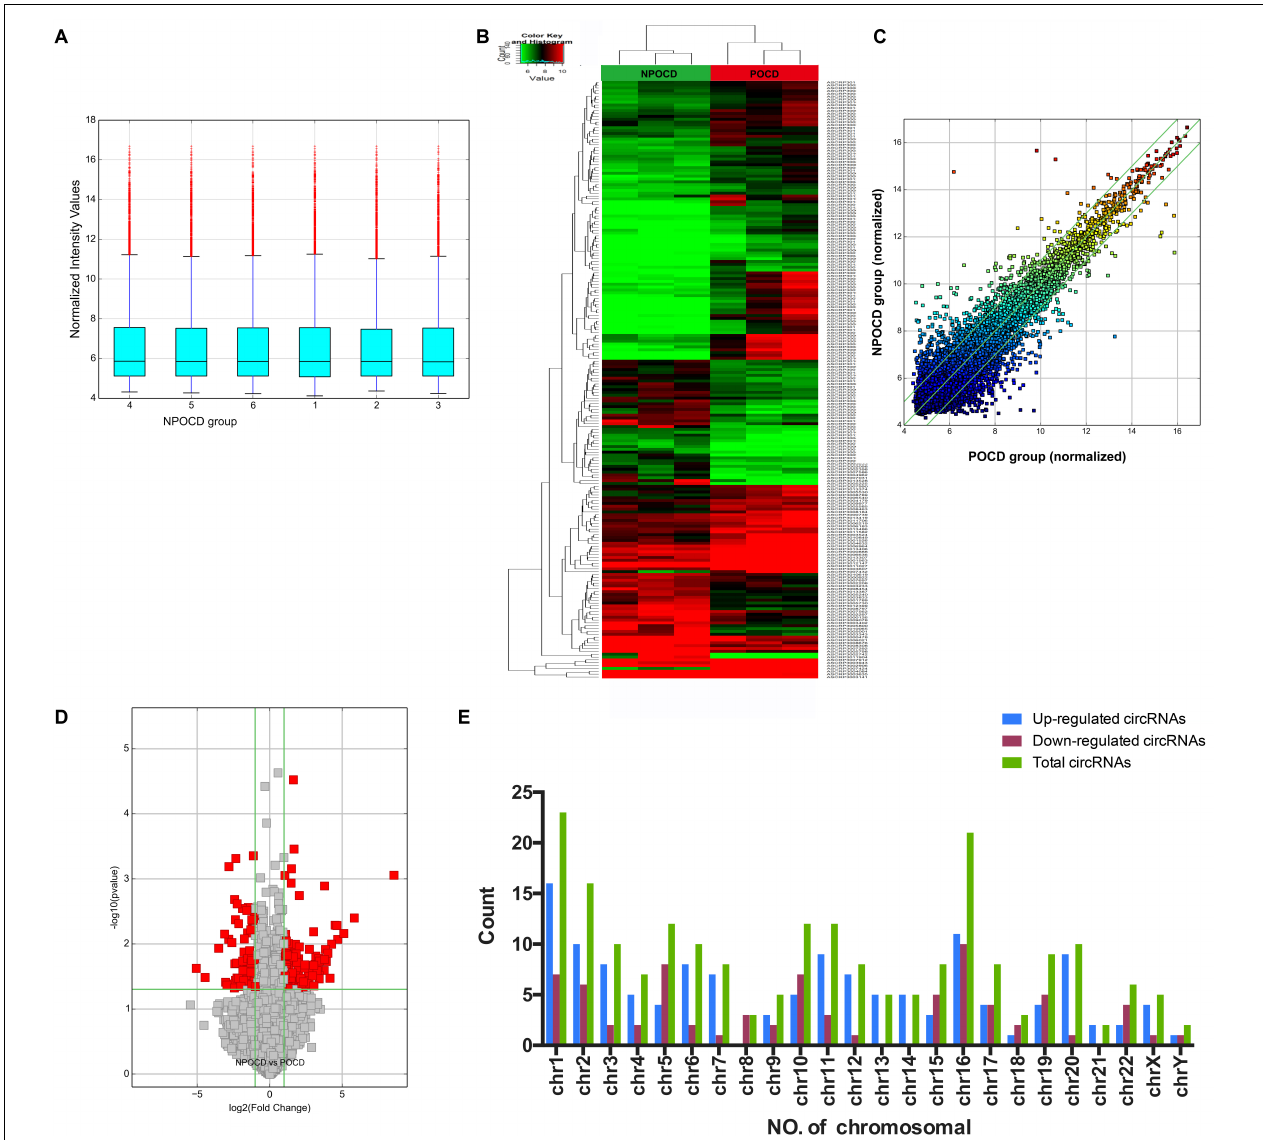
FIGURE 2 | Differentially expressed profile of circRNAs and characterization between the serum of postoperative cognitive dysfunction (POCD) and non-POCD patients. (A) Box plots showing the distribution of circRNAs between the serum samples. (B,C) Hierarchical clustering plot showing the differentially expressed circRNA profiles in the six samples. “Red” represents the higher expression, while “green” represents the lower expression level. (D) Volcano plots visualizing the distinguishable circRNA expression. (E) Chromosomal distributions of circRNAs in the two